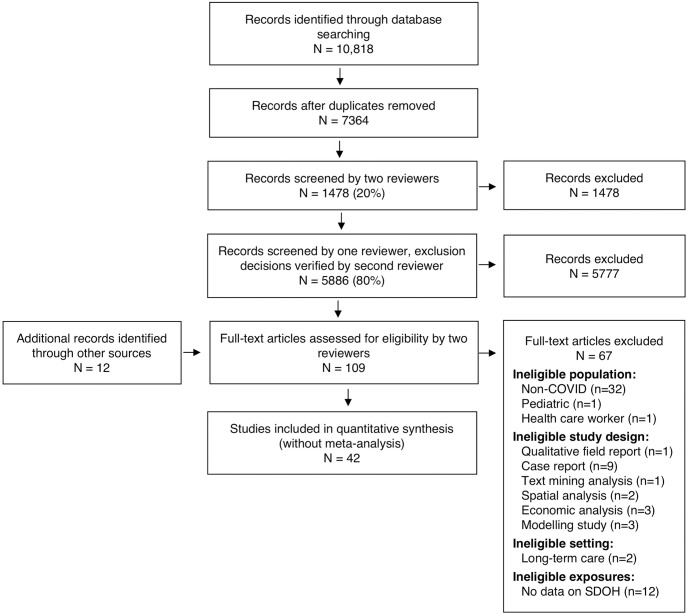
PRISMA flow diagram.